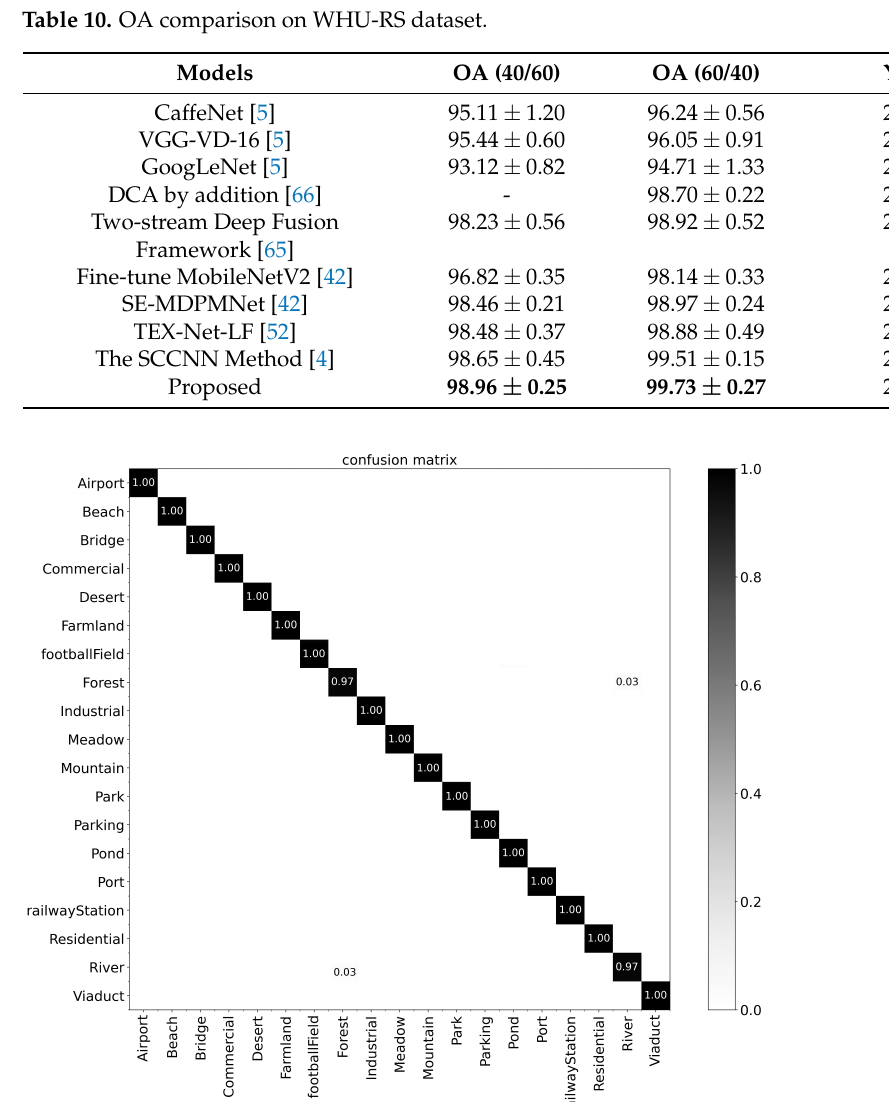
Figure 16. Confusion matrix of our model on WHU-RS dataset (train:test =